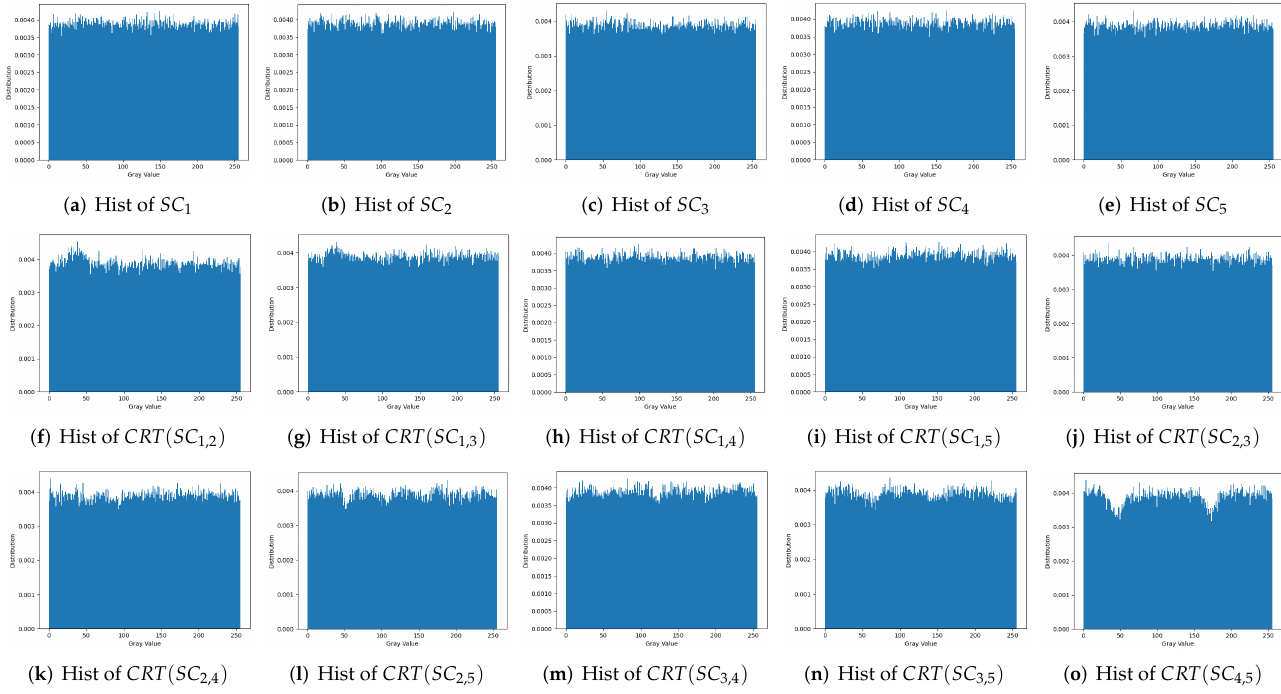
Figure 6. Histograms of the shares and recovered images with two shares in Figure